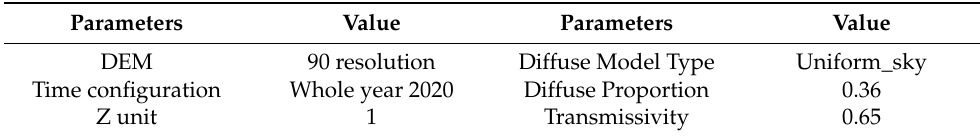
Table 6. Solar analyst tool